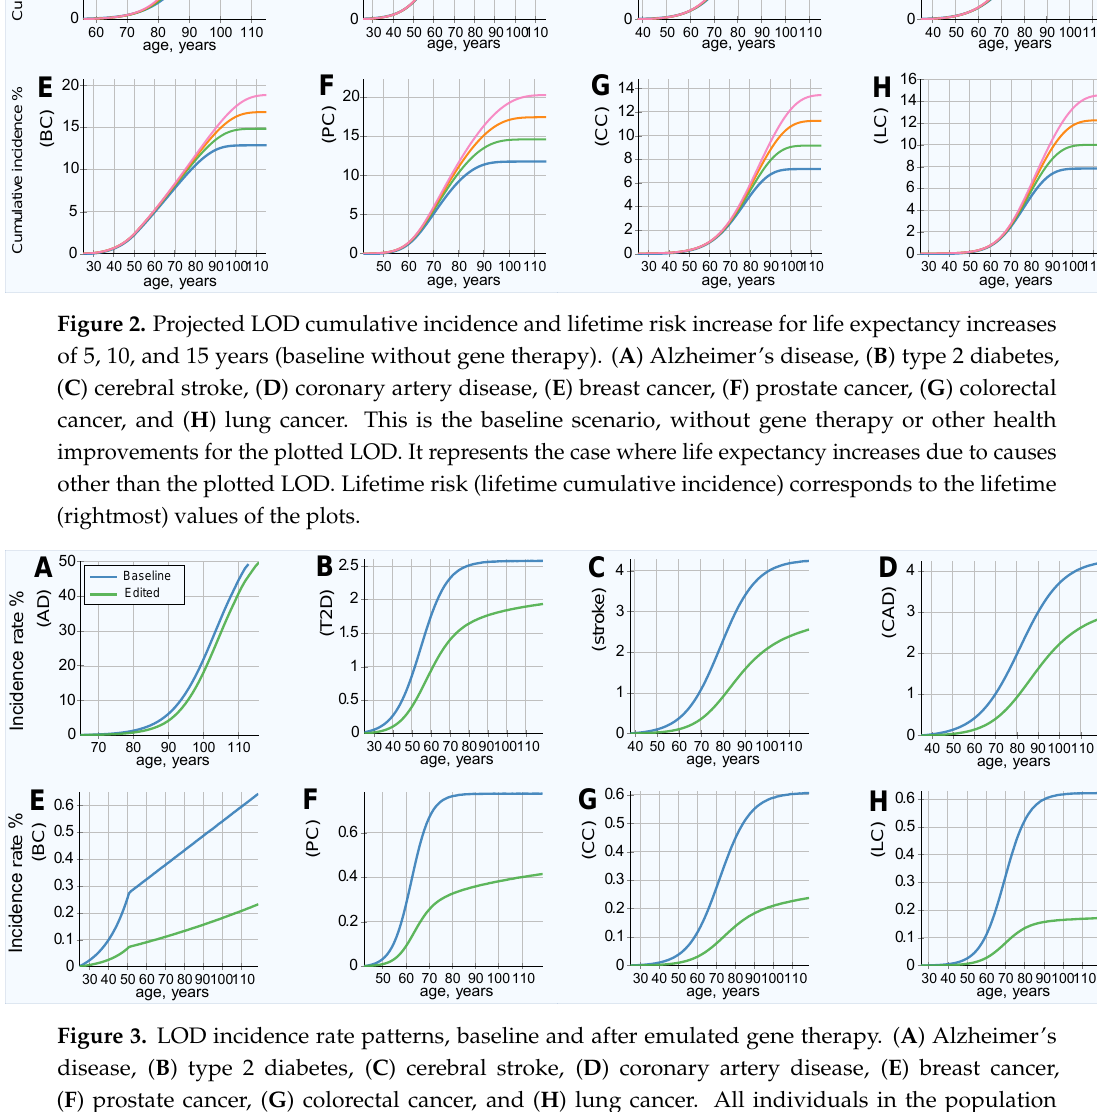
Figure 3. LOD incidence rate patterns, baseline and after emulated gene therapy. ( A ) Alzheimer’s disease, ( B ) type 2 diabetes, ( C ) cerebral stroke, ( D ) coronary artery disease, ( E ) breast cancer, ( F ) prostate cancer, ( G ) colorectal cancer, and ( H ) lung cancer. All individuals in the population had emulated corrective gene therapy editing of, on average, 15 single nucleotide polymorphisms (SNPs) (corresponding to an odds ratio (OR) multiplier of